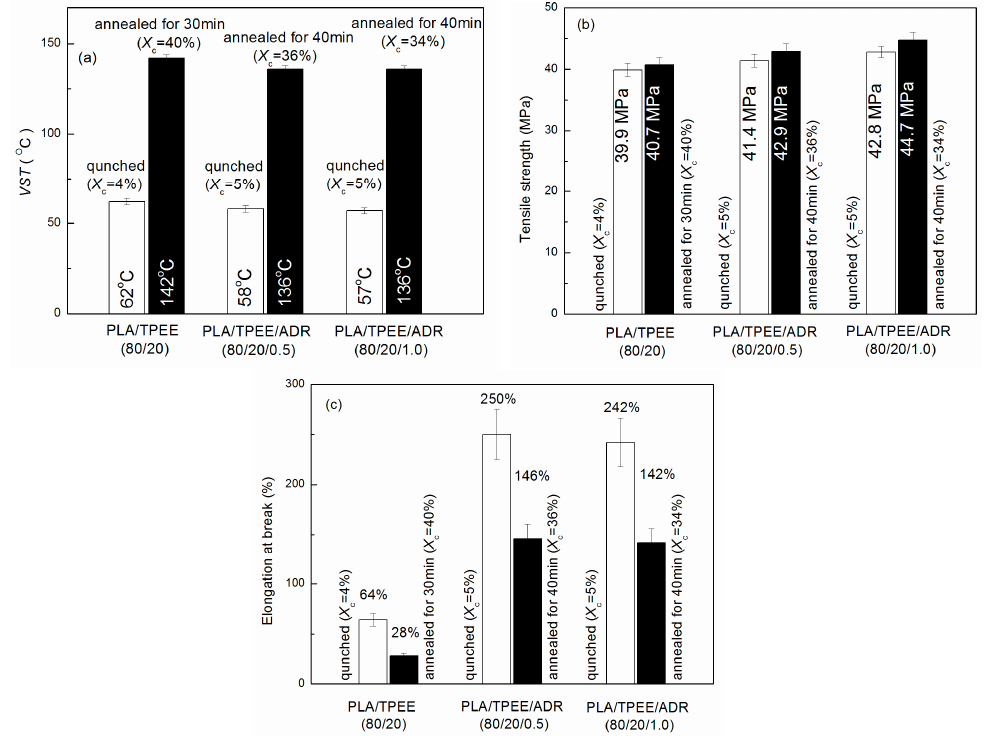
Figure 7. Effects of annealing and ADR loading on VST, tensile strength, and elongation at break of PLA/TPEE/ADR (80/20/ x ) samples: ( a ) VST; ( b ) tensile strength; and ( c ) elongation at break.